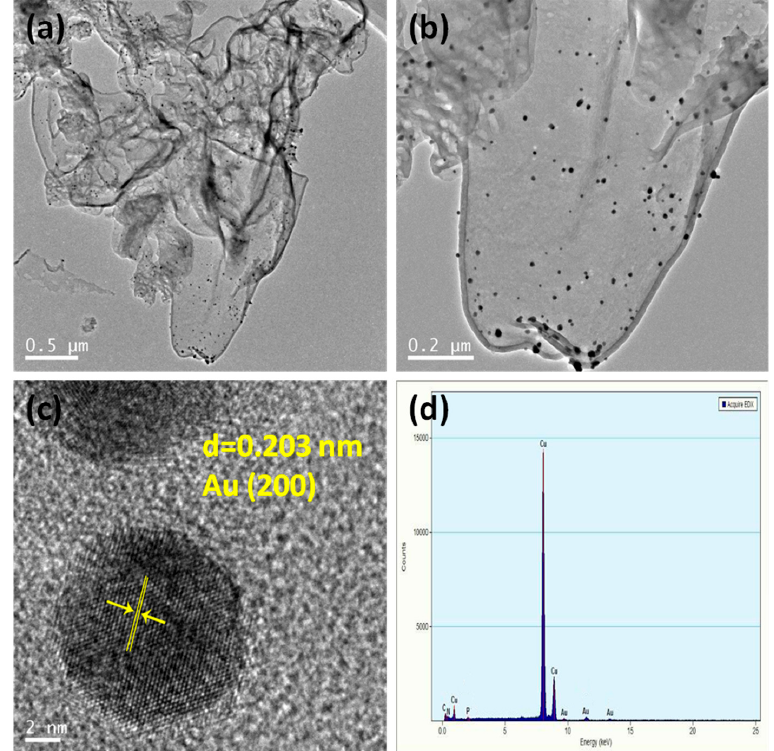
Figure 3. TEM image with low-magnification ( a ) of 3% Au/P-g-C 3 N 4 and high-magnification ( b ) of 3% Au/P-g-C 3 N 4 . ( c) Corresponding HRTEM image of a single Au nanoparticle and ( d ) EDS spectrum of 3% Au/P-g-C 3 N 4 . 3% Au / P-g-C 3 N 4 Table 2. Mean particle size and particle size distribution of all Au loaded samples.